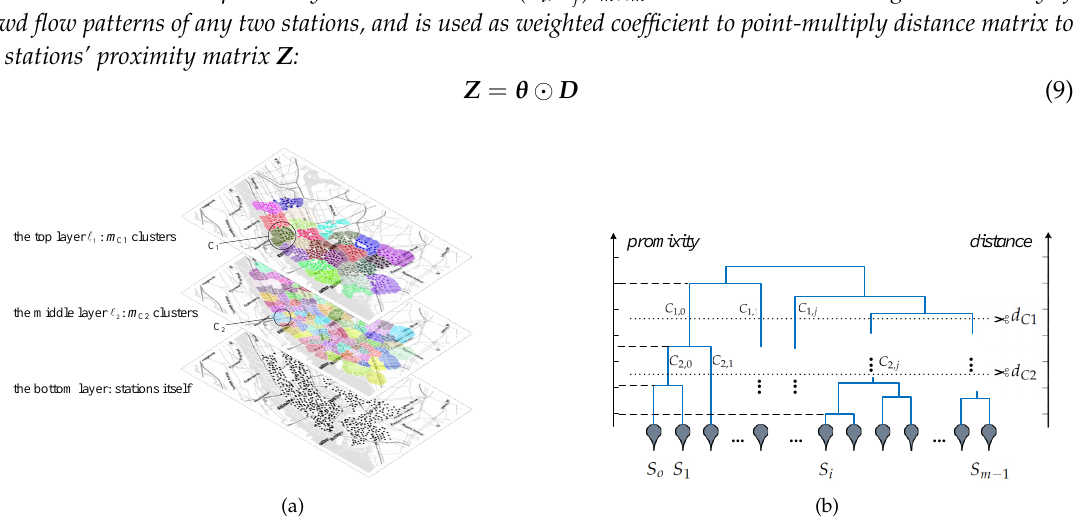
Figure 8. ( a ) The hierarchical structure of all stations; ( b ) the tree result from agglomerative